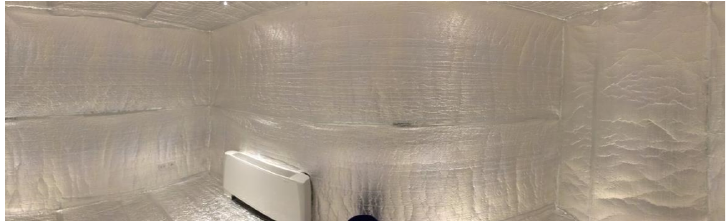
Figure 12. “Cold” laboratory